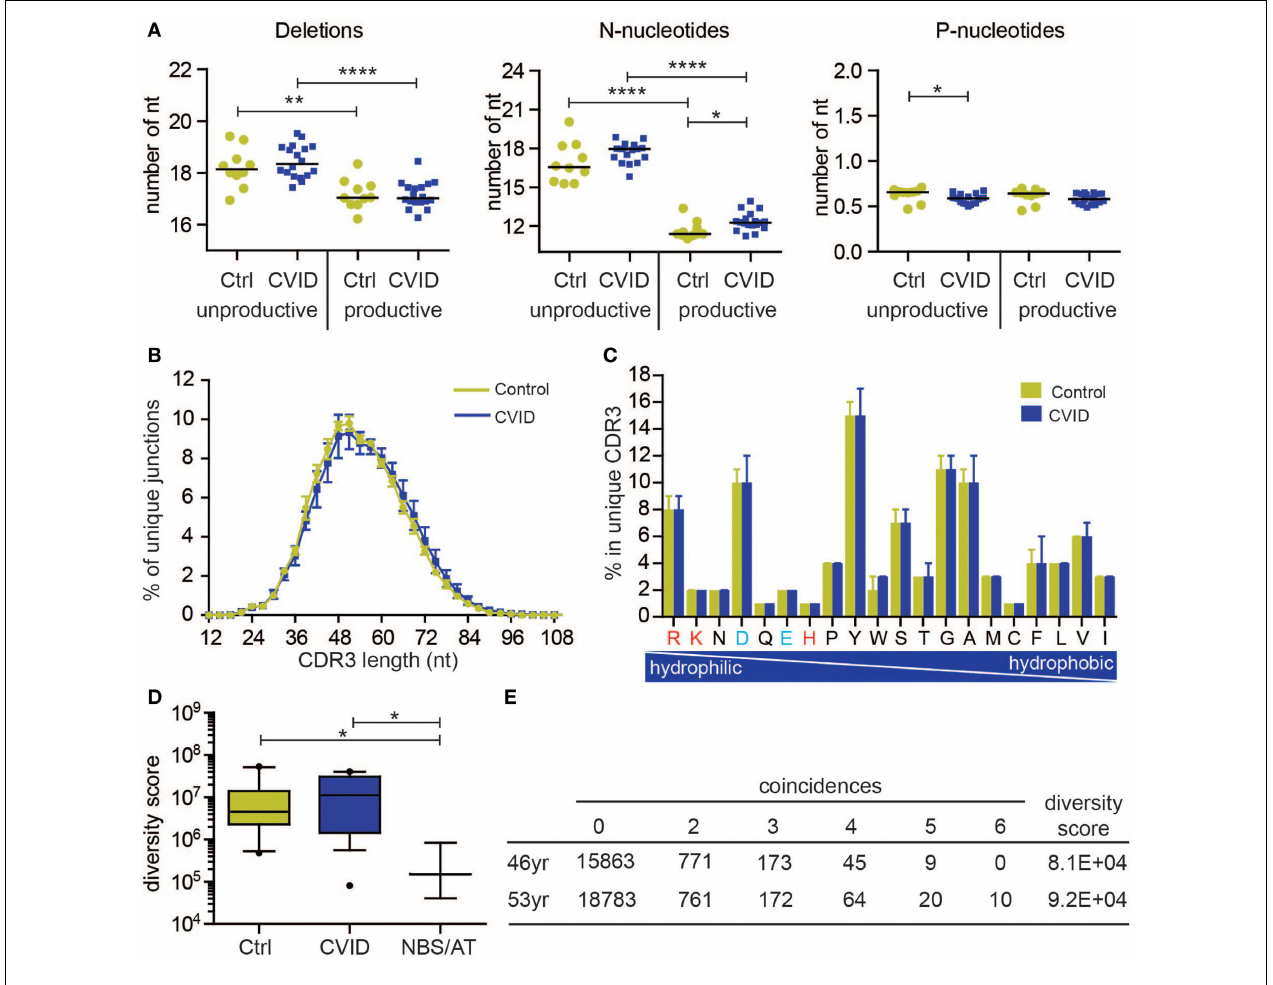
the frequency of amino acids in the CDR3 (median with range) is also comparable.The positively charged amino acids are indicated in red and the negatively charged in blue. (D) The diversity of the naive B-cell repertoire in CVID patients is comparable to controls, however one patient has a very restricted repertoire similar to patients with Nijmegen breakage syndrome (NBS) and ataxia telangiectasia (AT). Data are shown in box and whiskers (10–90 percentile). (E) The repertoire of this patient remains very restricted over time. * p < 0.05, ** p < 0.01, *** p < 0.001, **** p <